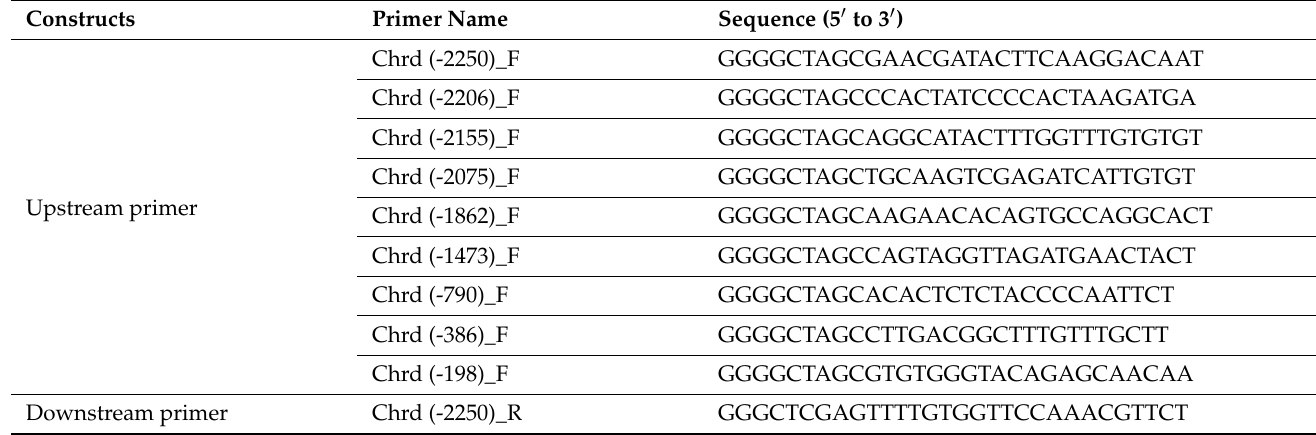
Table 1. Primers used for serially deleted chrd(-2250) promoter